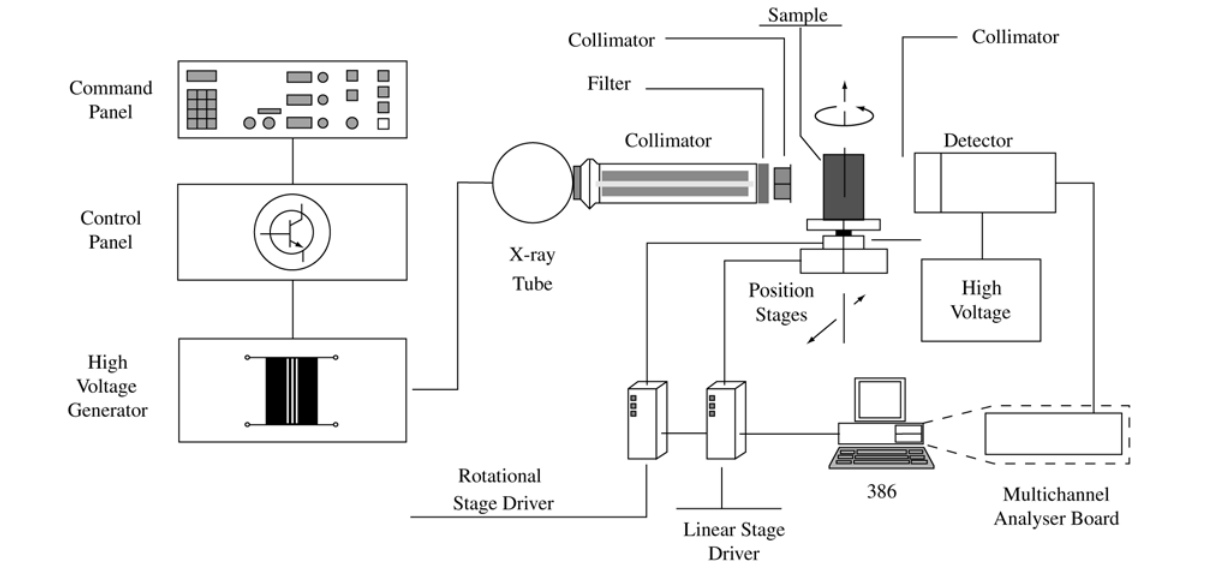
Figure 1. Block diagram of the CT